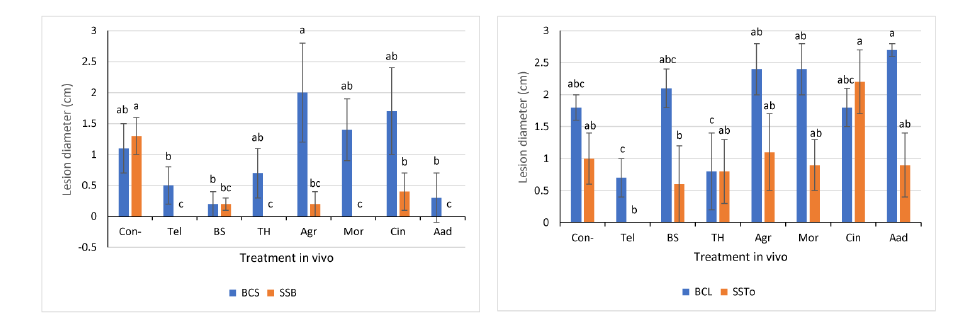
Figure 3 Effect of different treatments on lesion diameter. ( A ) BCS versus SSB isolates; ( B ) BCL versus SSTo isolates. Each different letter indicates significant difference among treated lettuce leaves compared to the controls according to Duncan’s test ( p <